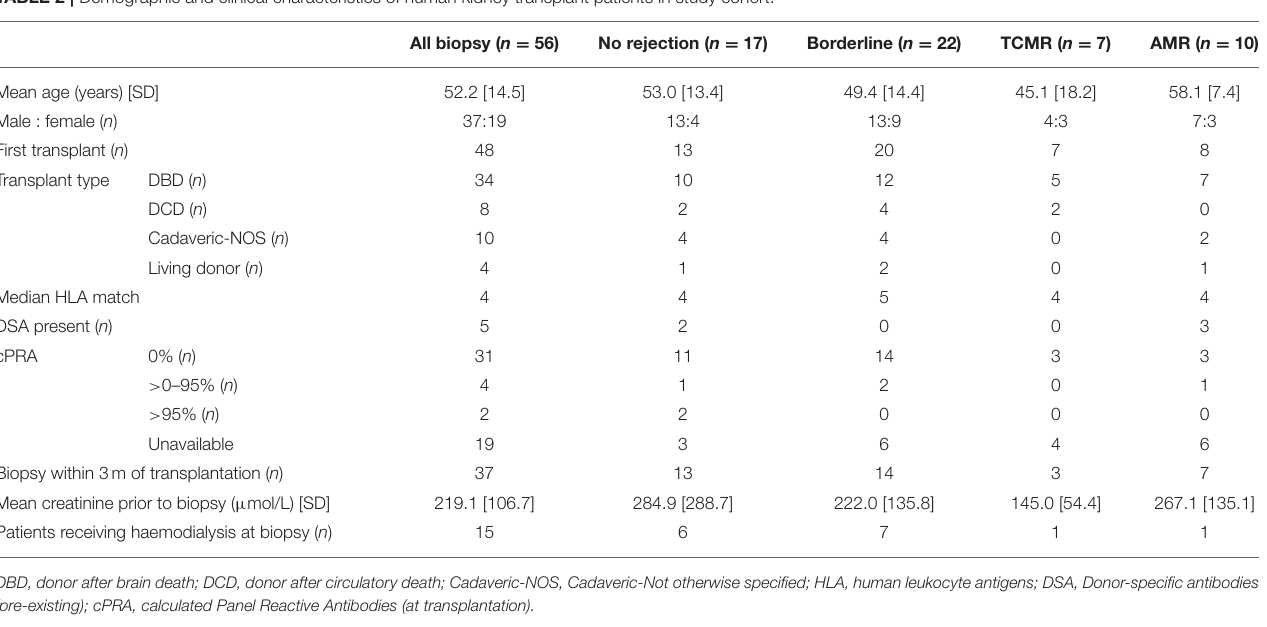
TABLE 2 | Demographic and clinical characteristics of human kidney transplant patients in study cohort. All biopsy ( n = 56) No rejection ( n = 17) Borderline ( n = 22) TCMR ( n = 7)